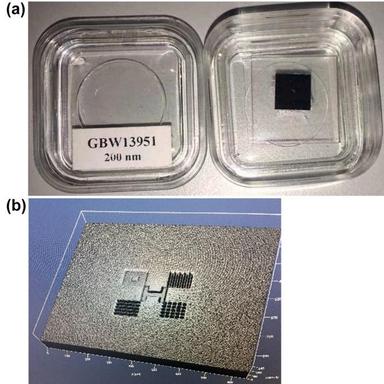
The standard provided by NIM: (a) Photograph of the standard; (b) 50X Magnification of the surface by Confocal Microscopy, Zeiss LSM 710.